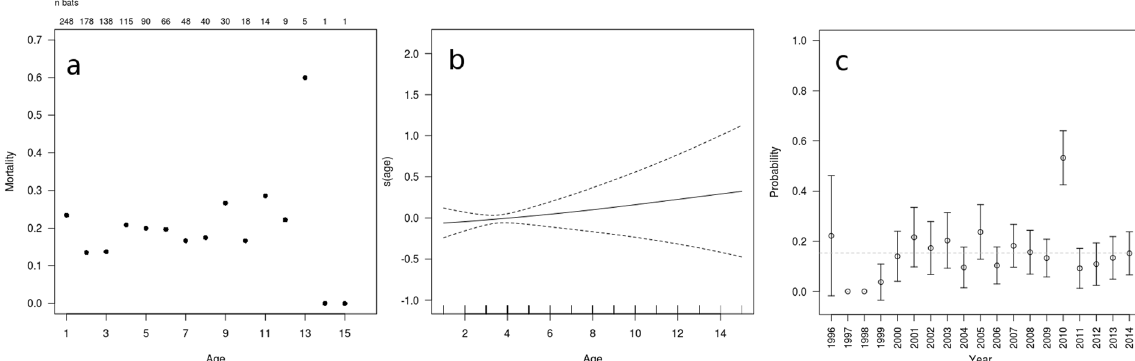
Figure 2. ( a ) Observed annual probability of death in each age class. ( b ) The corresponding estimation result for the hazard regression from model 7 from Table 1 with age as a smooth function on logit scale ± 2 s.e., and ( c ) environmental fluctuations via variable year (age and size fixed at their medians. Dashed horizontal line indicates mean; 95% confidence intervals added).